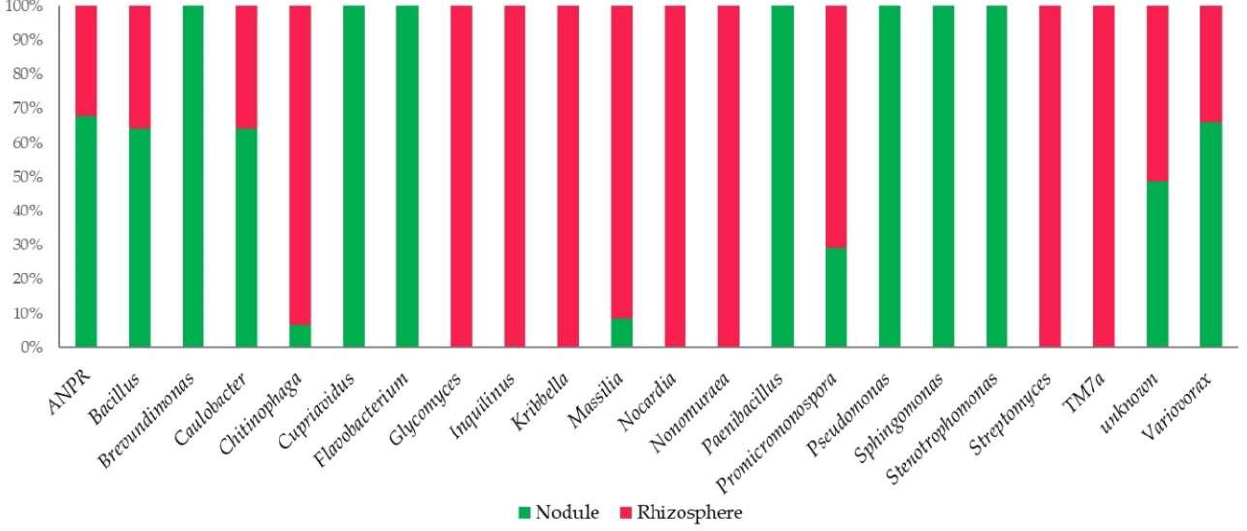
Figure 3. Amplicon sequence variants (ASVs) distribution at the genus level (0.5% cutoff) in the